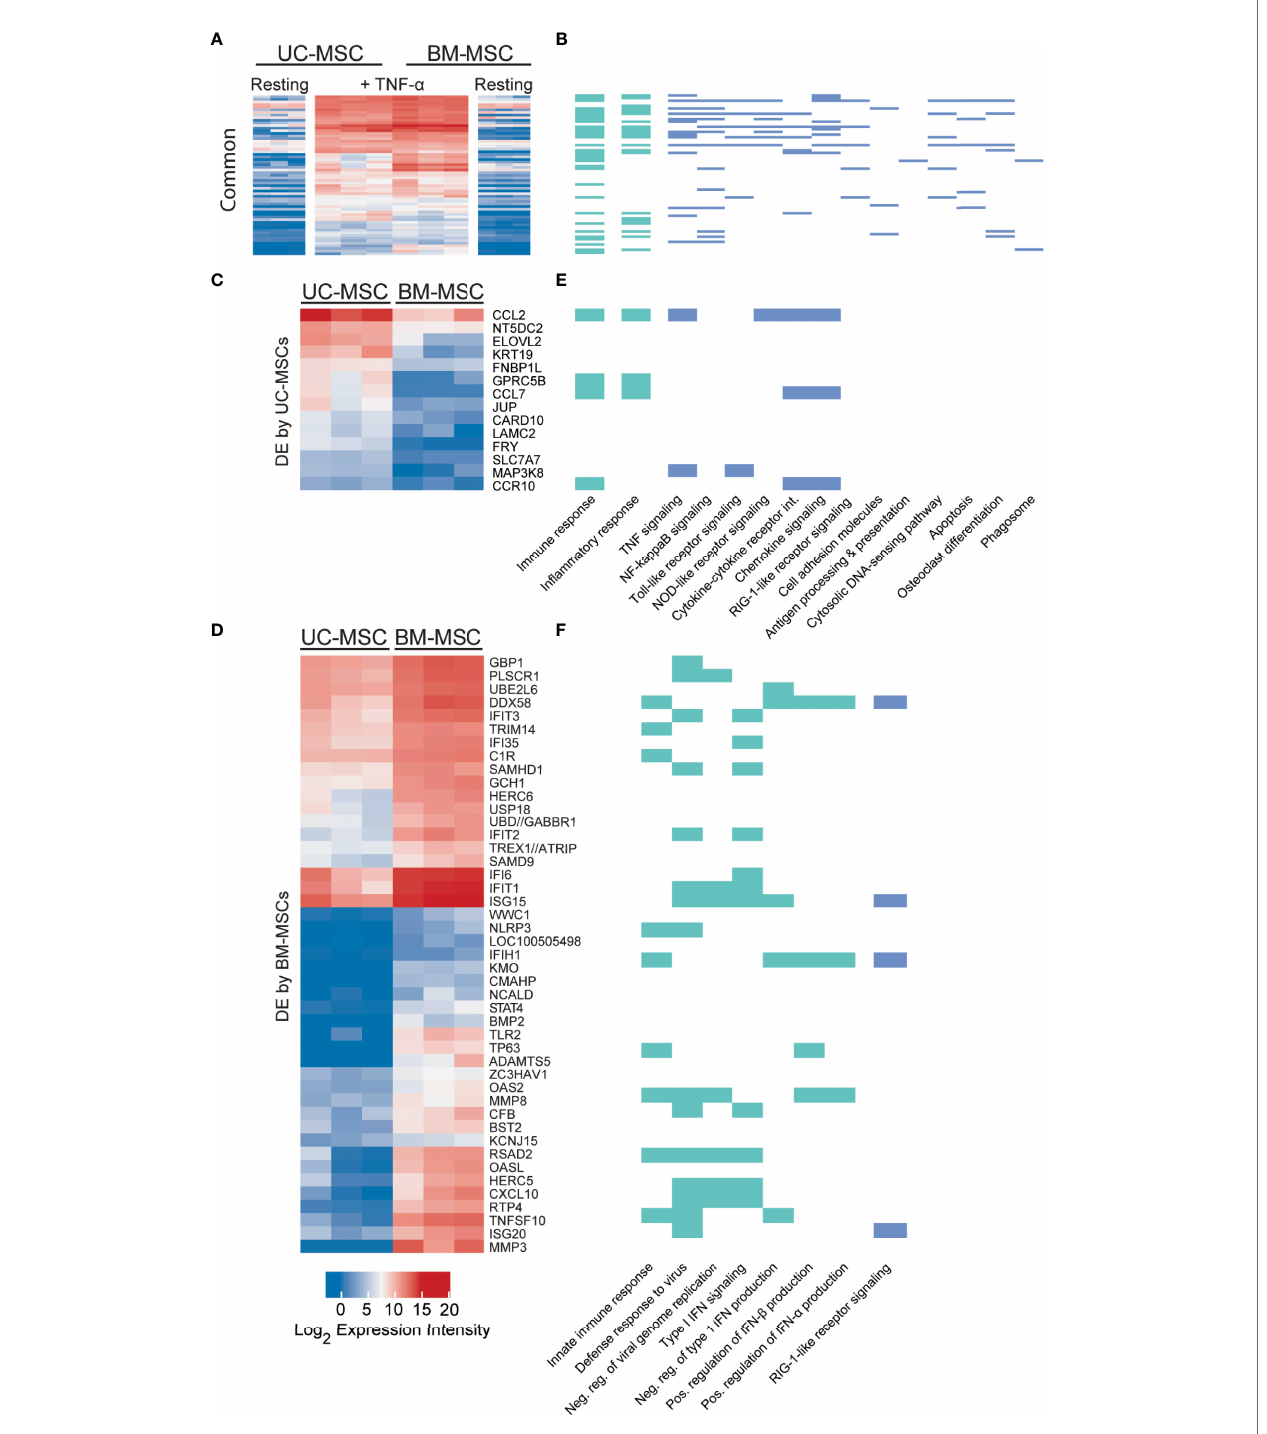
FIGURE 2 | TNF- a resolves all but 7 differentially expressed genes in unstimulated MSCs and evokes source-speci fi c activation signatures. (A) Sixty-one genes are activated to comparable levels after licensing of UC and BM-MSCs by TNF- a . (B) Most of these genes are linked to enriched GO Biological Process terms are indicated in (green), and enriched KEGG pathways (blue (p<0.05) related to immunity and in fl ammation. (C) Thirteen genes are upregulated in TNF- a licensed UC-MSCs statistically higher than activated BM-MSCs. (D) Forty- fi ve genes are statistically upregulated in DE genes TNF- a licensed BM-MSCs. (E) UC-MSCs preferentially express genes linked to immunity, in fl ammation and cytokine and chemokine signaling, while (F) BM-MSCs increase expression of genes linked to innate immune function and Type I IFN signalling. BM, bone marrow; DE, differentially expressed; MSC, mesenchymal stromal cell; UC, umbilical